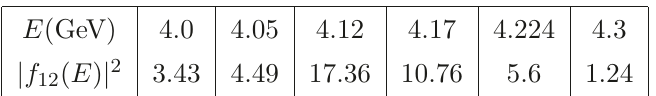
2 near the channel thresholds for the transition 1) . f 12 ( E ) | | J/ψ + φ D s + ¯ D s →